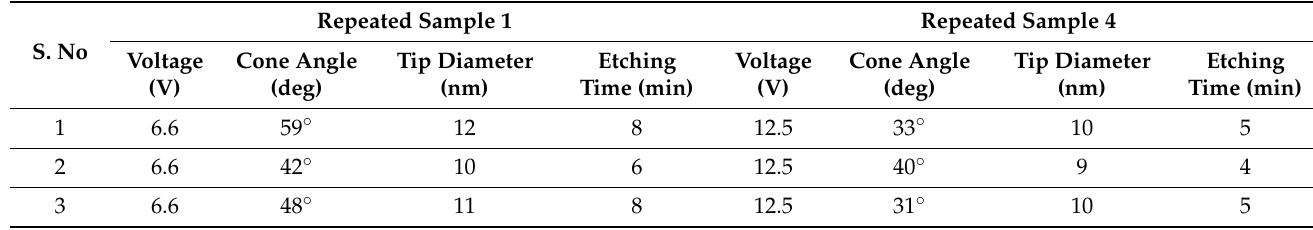
Table 6. Experimental results for 0.4 mm tips showing optimal results of Sample 1 and 4 produced in 2 M NaOH solution on DC Etching.